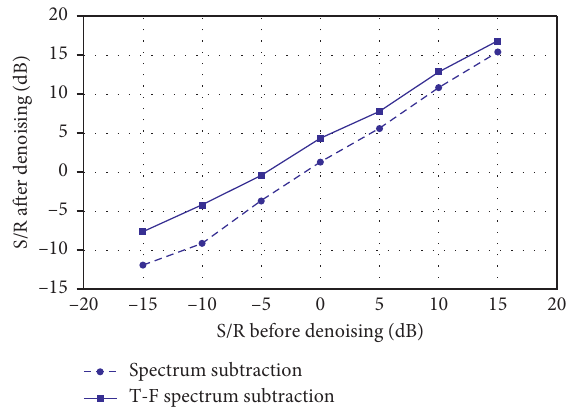
Figure 10: Comparison of S/R of the sigmoid model before and after